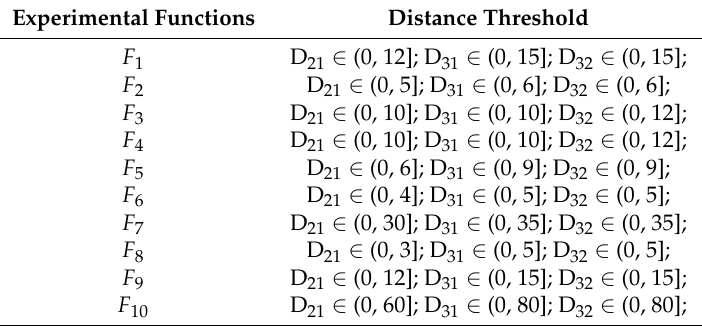
Table 6. Parameter settings of